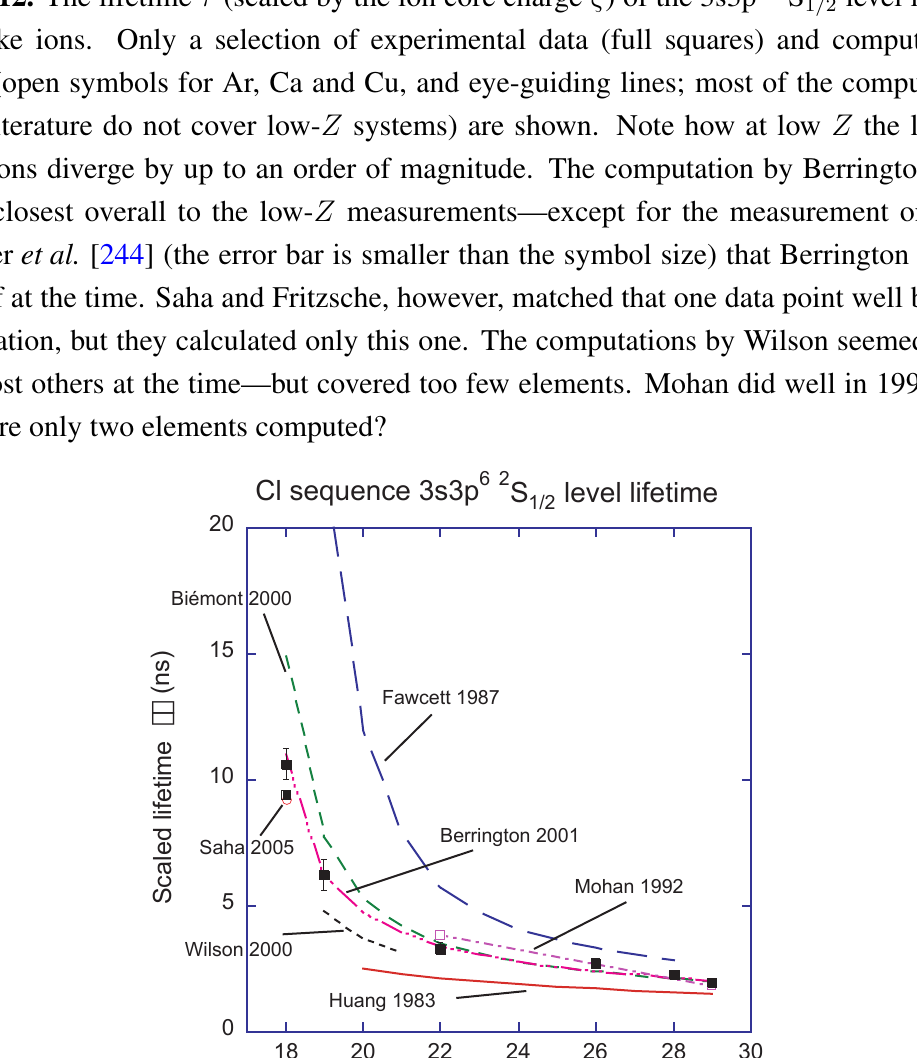
level lifetime 1 / 2